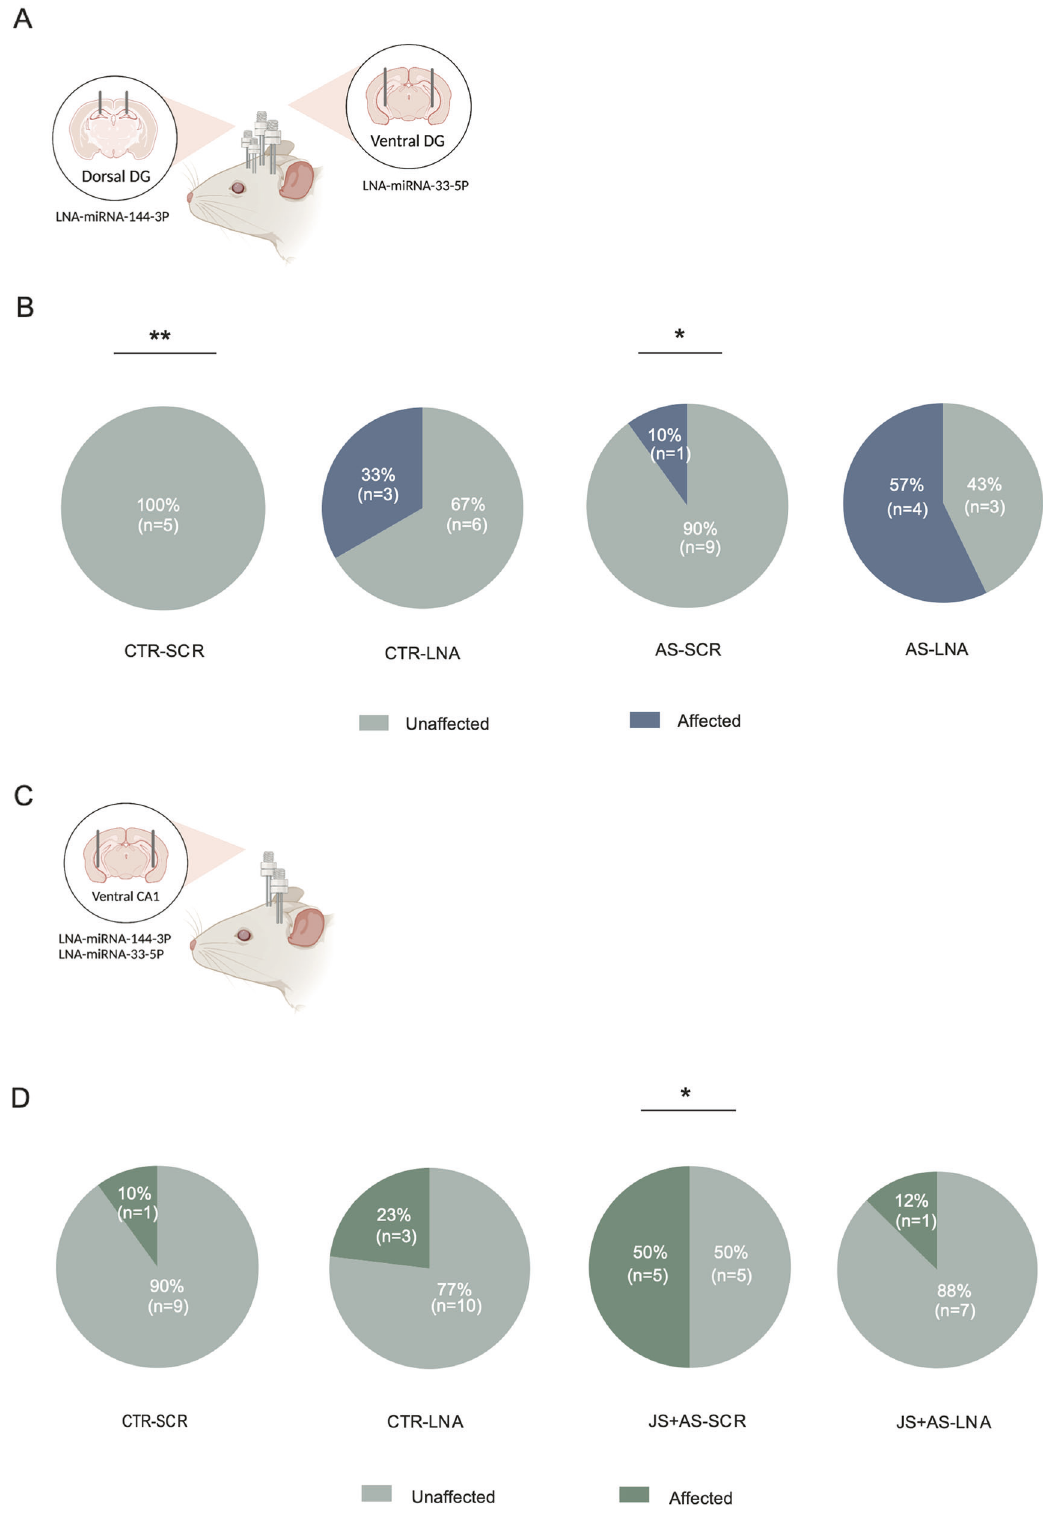
Fig. 5 Behavioral pro fi les following miRNA-144 and miRNA-33 LNA inhibition in males and females. A Schematic of cannula implantations in males. B In male rats, behavioral pro fi ling revealed an increased prevalence of affected rats in the AS-LNA group compared to that in the AS-CTR group. Number of animals: CTR-SCR: n = 7, CTR-LNA: n = 8, AS-SCR: n = 10, AS-LNA = 7. All values are mean ± SEM. C Schematic of cannula implantations in females. D In female rats, behavioral pro fi ling revealed an increased prevalence of unaffected rats in the JS + AS-LNA group compared to that of the JS + AS-SCR rats. Number of animals: CTR-SCR: n = 10, CTR-LNA: n = 13, JS + AS-SCR: n = 10, JS + AS-LNA = 8. Values are the % and number of affected and unaffected animals in each group. *Different from JS + AS-SCR, p < 0.005. Translational Psychiatry